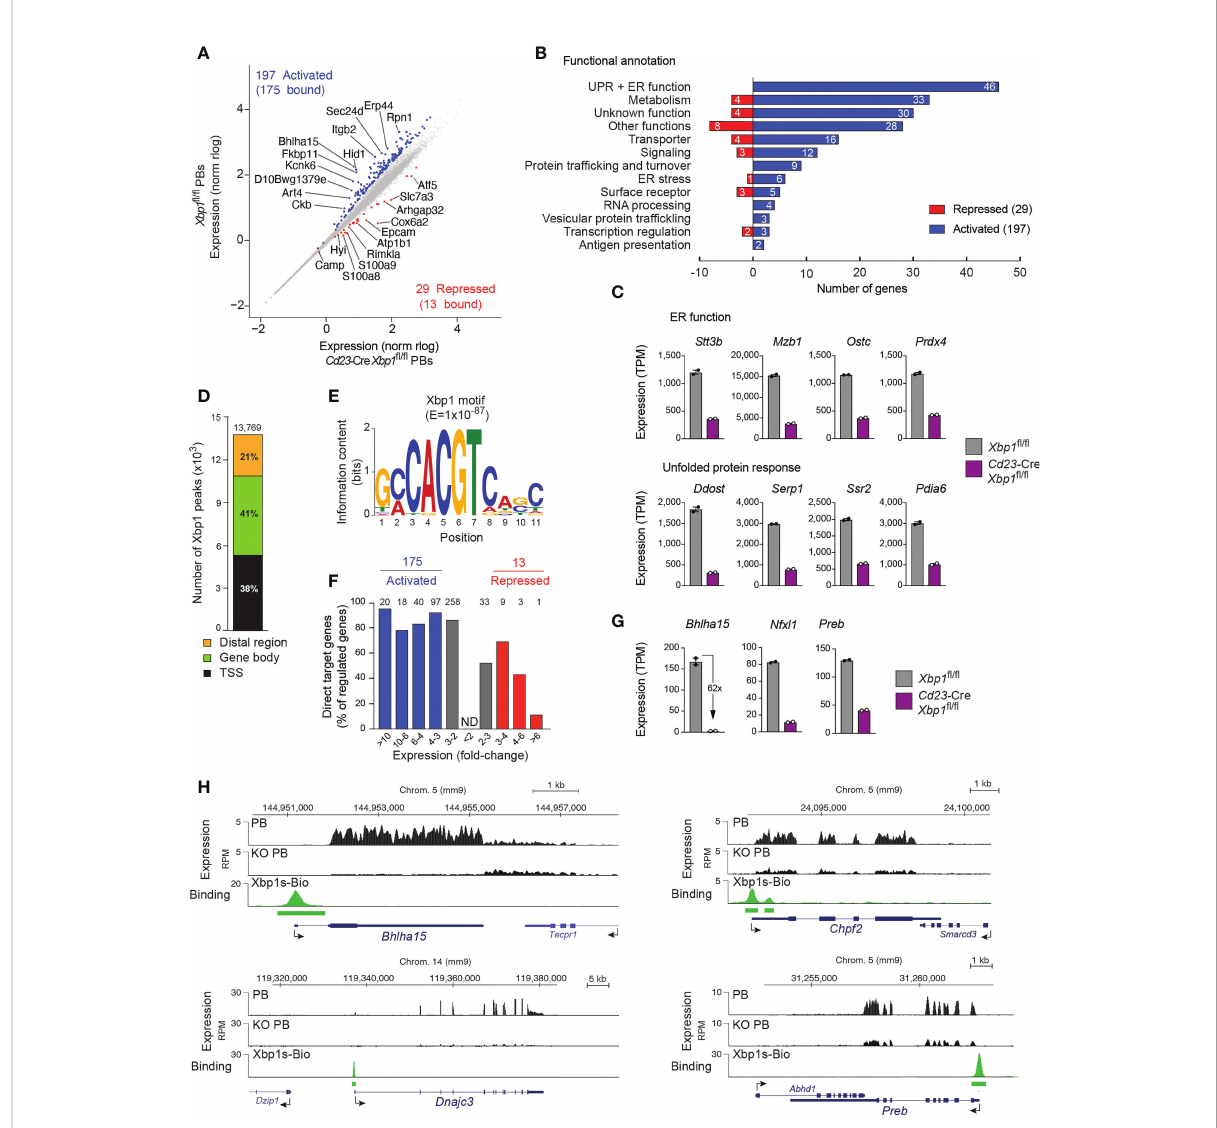
FIGURE 1 Xbp1-dependent gene expression program in plasmablasts. (A) Scatter plot of gene expression differences between Cd23 -Cre Xbp1 fl / fl and Xbp1 fl / fl PBs that were sorted as CD19 + CD138 + CD23 – cells after stimulation in the iGB system for 4 days with IL-4 followed by 4 days with IL-21. Two independent RNA-seq experiments were performed with PBs of each genotype. Each dot corresponds to one gene, whose expression is plotted as normalized log 10 (norm rlog) expression value. Genes with an expression difference of > 3-fold, an adjusted P value of < 0.05, a transcripts per million (TPM) expression value of > 5 (at least in one sample) are colored in blue or red corresponding to activation or repression by Xbp1, respectively. (B) Functional classi fi cation and quanti fi cation (number) of proteins encoded by Xbp1-activated and Xbp1-repressed genes. (C) Expression of genes involved in UPR or ER function, shown as mean TPM values of two RNA-seq experiments of Cd23 -Cre Xbp1 fl / fl or Xbp1 fl / fl PBs, respectively. (D) Presence of Xbp1 peaks in distal regions, gene bodies and promoter (TSS) regions. Splenic B cells from Xbp1 Bio/Bio Rosa26 BirA/+ mice were stimulated for 4 days with LPS followed by Bio-ChIP-seq analysis. The Xbp1 peaks were assigned to genes as described (22). (E) Consensus Xbp1-binding motif identi fi ed with an E-value of 1 x 10 -87 by the de novo motif-discovery program MEME-Chip. (F) The number of regulated target genes is shown for the indicated fold-change of gene expression between Cd23 -Cre Xbp1 fl / fl and Xbp1 fl / fl PBs. Grey bars indicated activated or repressed genes with less than a 3-fold expression change. (G) Expression of Xbp1-activated transcription factor genes in Cd23 -Cre Xbp1 fl / fl and Xbp1 fl / fl PBs, shown as mean TPM values of two RNA-seq experiments per genotype. (H) Xbp1 binding and RNA-seq expression at selected activated Xbp1 target loci. Horizontal bars indicate Xbp1s-Bio peaks identi fi ed by MACS peak